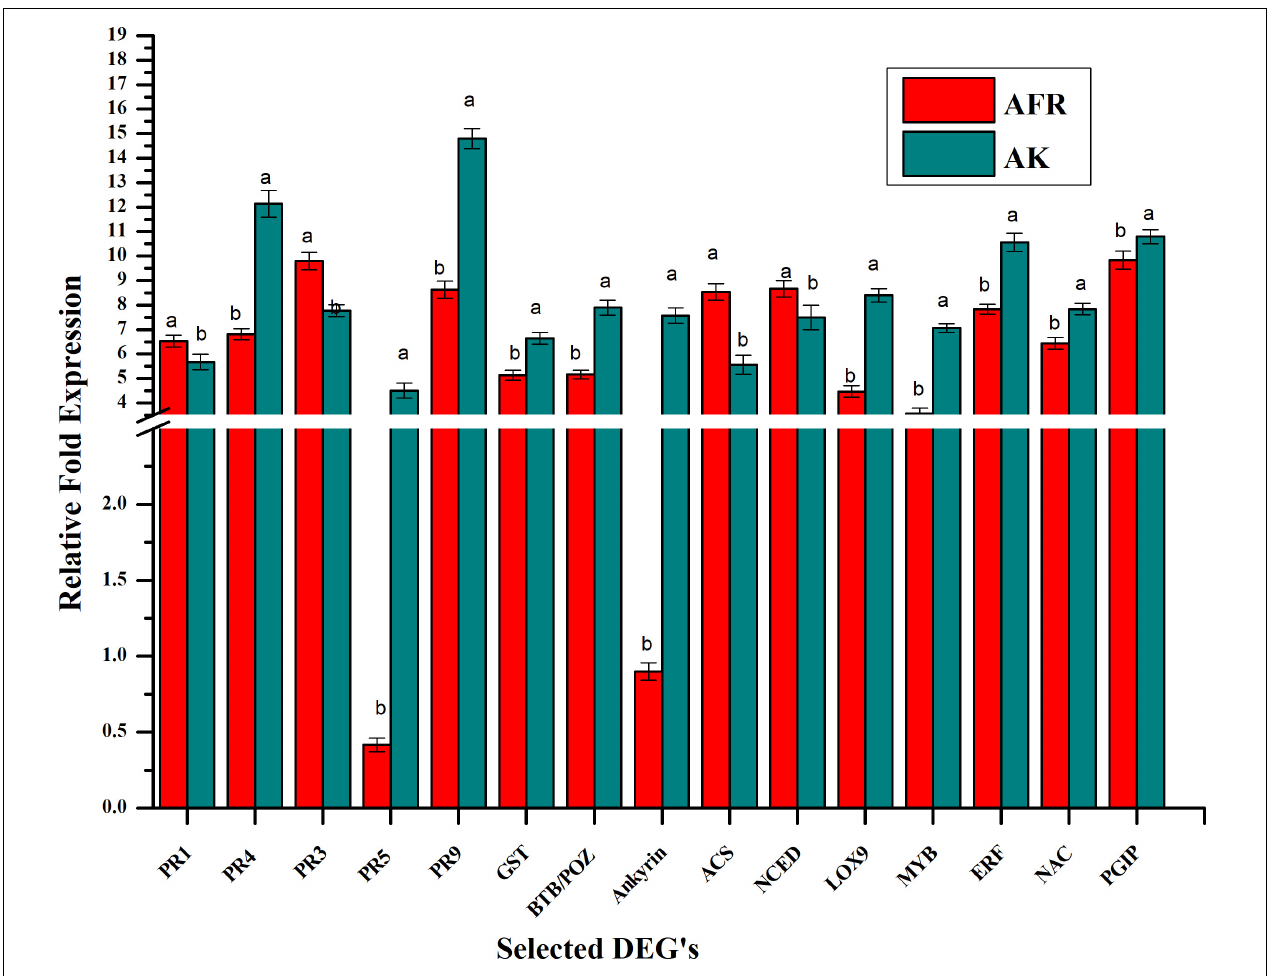
FIGURE 4 | Validation selected differentially expressed genes by relative qPCR analysis in AK and AFR at 5 dpi. Data refer to the most representative of two independent repeated experiments. Each reaction was performed in triplicate, and values represent the average of these three technical replicates. Error bar showed the standard error of the mean, and different letters suggest statistically significant differences as per Duncan’s multiple range test ( p <